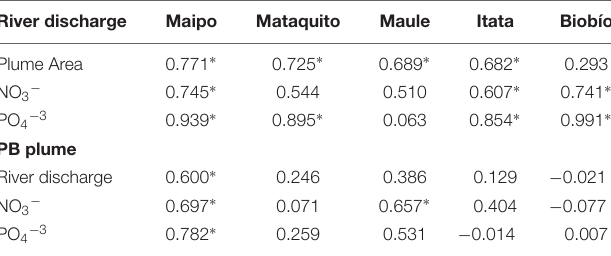
TABLE 2 | Spearman correlation coefficients (rs) for the Maipo, Mataquito, Maule, Itata, and Biobío Rivers using 15 years of mean annual values of river discharge (m 3 s − 1 ), river plume area (km 2 ), Nitrate- NO 3 − , and Phosphate-PO 4 − 3 export (Ton month − 1 ) and phytoplankton biomass plume (Chlorophyll; mg m − 3 ).